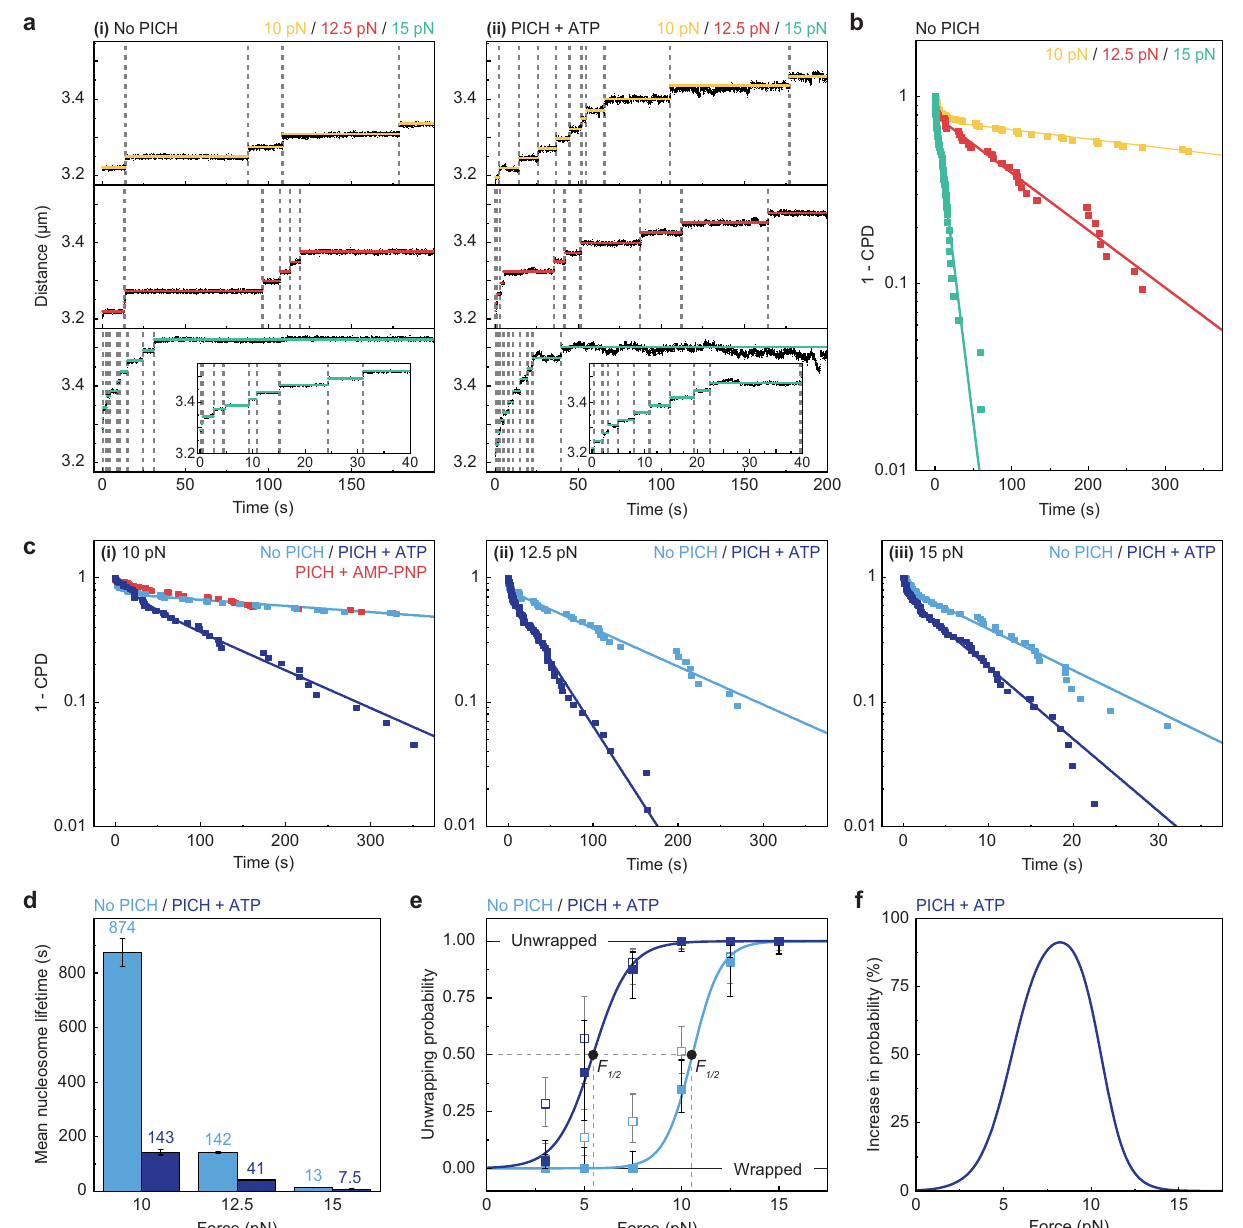
Fig. 3 | PICH decreases nucleosome lifetimes and lowers the force required to achievenucleosomeunwrapping.a RepresentativeDistance-Timetracesshowing inner-turn-unwrapping events of nucleosomes at 10pN, 12.5pN and 15pN, in the absence ( i ) and presence ( ii ) of PICH and ATP. Horizontal lines indicate segments detected by a step- fi tting algorithm (see Methods). Unwrapping events are high- lighted bythe verticaldashed lines. b CPDs of nucleosome lifetimes in the absence of PICH at a constant force of 10, 12.5 or 15pN, respectively. Solid lines display the correspondingbi-exponentialdecay fi ts. N =50,41and48nucleosomelifetimesfor 10, 12.5 and 15pN, respectively. c CPDs of the nucleosome lifetimes shown in ( b ) (light blue) and CPDs of nucleosome lifetimes in the presence of PICH and ATP (purple) at 10pN ( i ); 12.5pN ( ii ); and 15pN ( iii ). Solid lines display the corre- sponding bi-exponential decay fi ts. N =45, 74 and 67 nucleosome lifetimes in the presenceof PICHandATPfor10,12.5and15pN,respectively.Reddatapointsin( i ) showtheCPDofnucleosomelifetimes( N =34)at10pNinthepresenceofPICHand ATP (Fig. 3c, (i)),consistent with our earlier fi nding thatATP hydrolysis is required to stimulate unwrapping. At higher tensions (12.5 and 15pN), the effect of PICH on the mean nucleosome lifetime was less pronounced, with a 3.5- and 1.7-fold reduction, respectively (Fig. 3d).